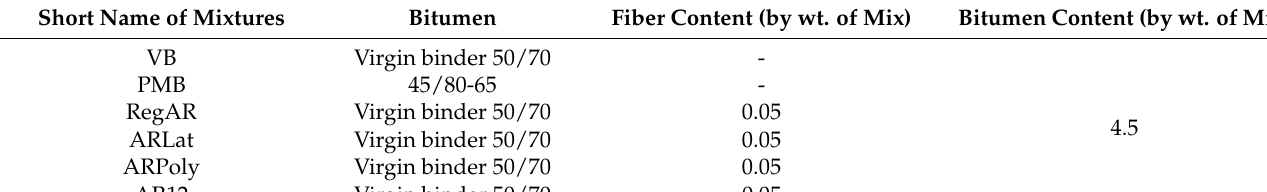
Table 3. Porous asphalt mixtures used in the study.